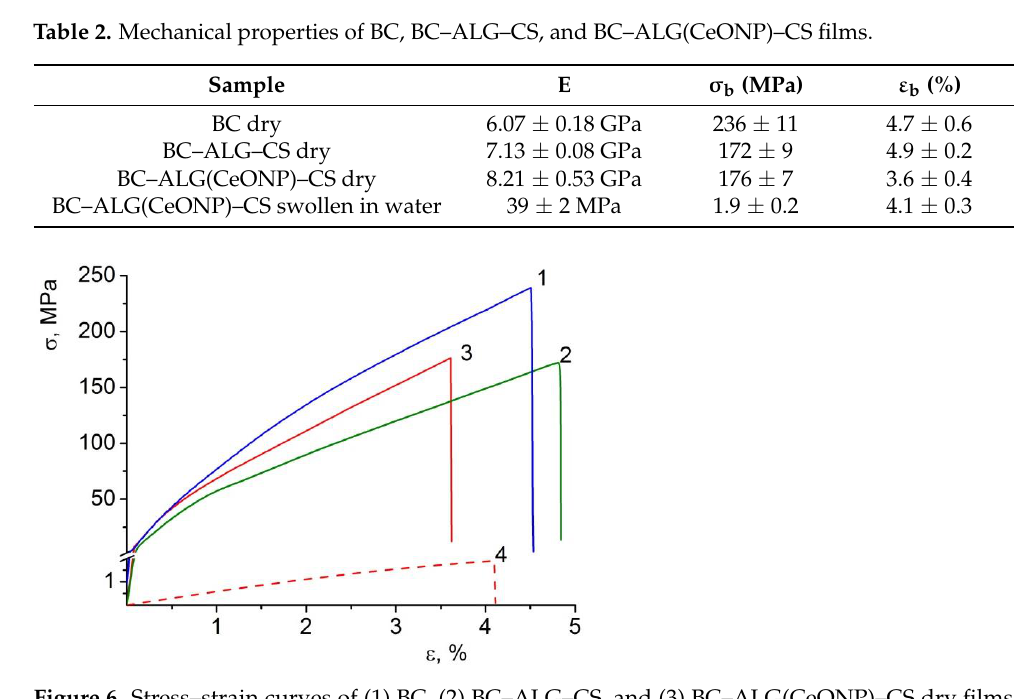
Figure 6. Stress – strain curves of (1) BC, (2) BC – ALG – CS, and (3) BC – ALG(CeONP) – CS dry films, and (4) BC – ALG(CeONP) – CS film swollen in water. and (4) BC–ALG(CeONP)–CS film swollen in